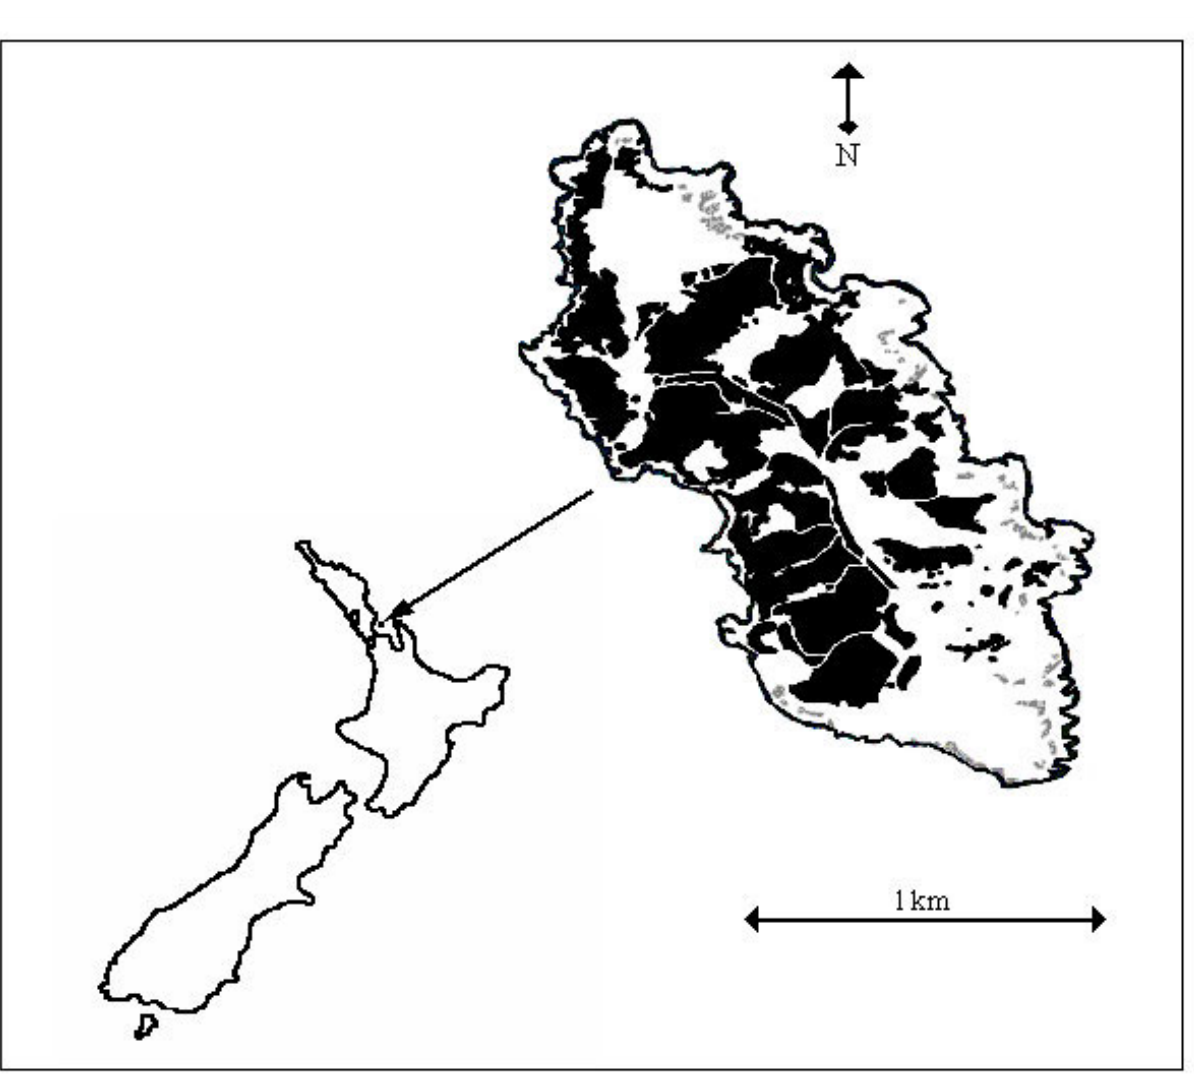
Fig. 1 . Map of Tiritiri Matangi Island (36°36’S, 174°53’E), New